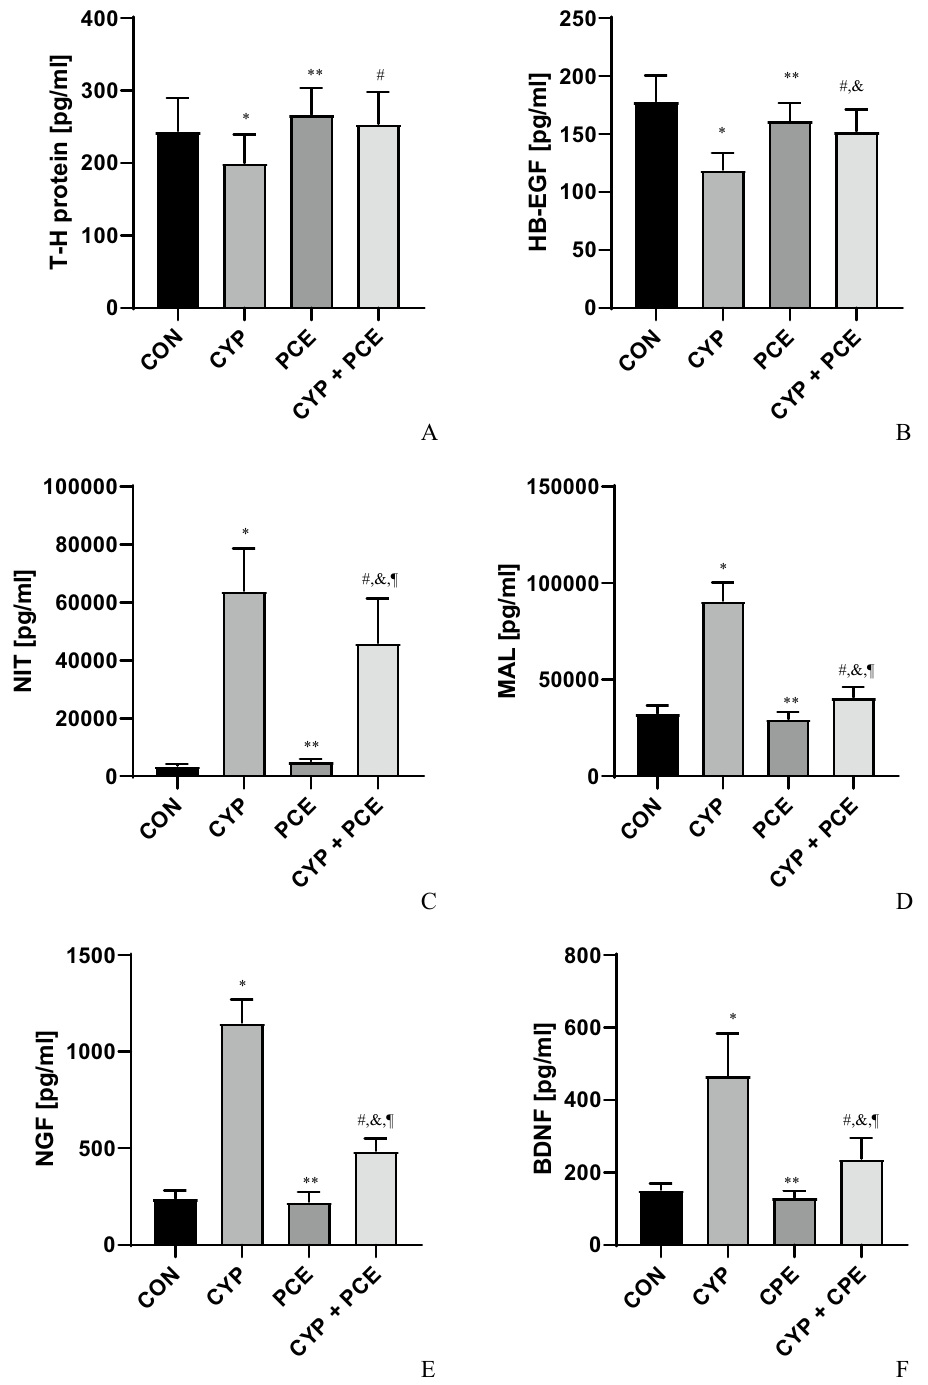
Figure 5. The influence of cyclophosphamide (CYP) and Potentilla chinensis aqueous extract (PCE) in naïve rats and PCE in rats with CYP-induced cystitis on the level of ( A ) T–H protein, ( B ) HB-EGF, ( C ) NIT, ( D ) MAL, ( E ) NGF, ( F ) BDBF in